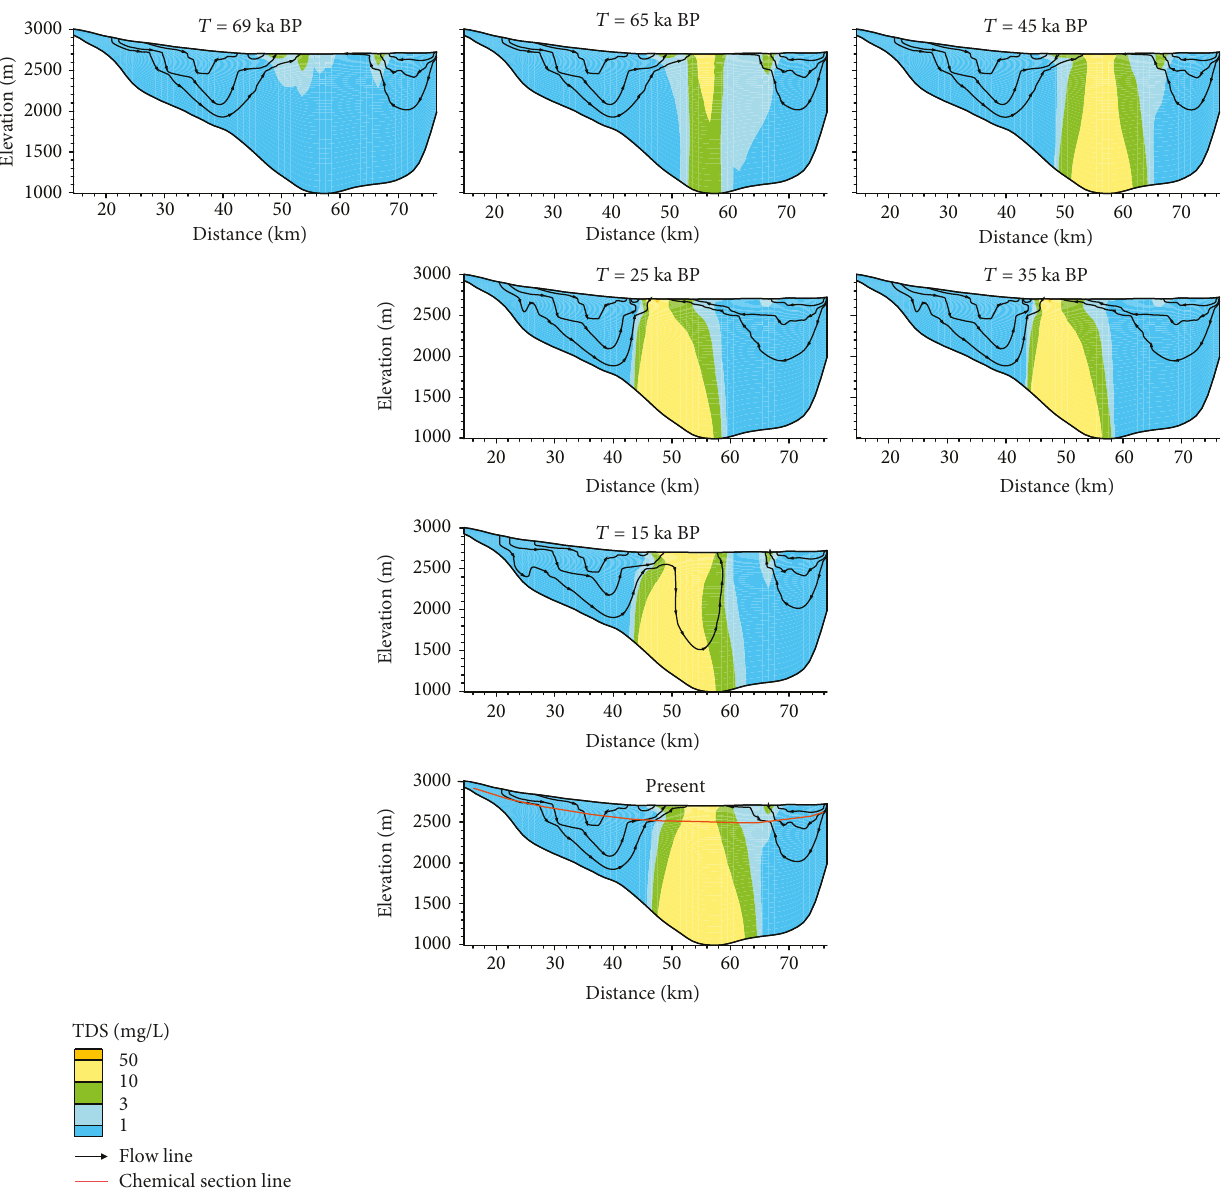
Figure 8: Evolution of the TDS concentrations during di ff erent geological periods (units: